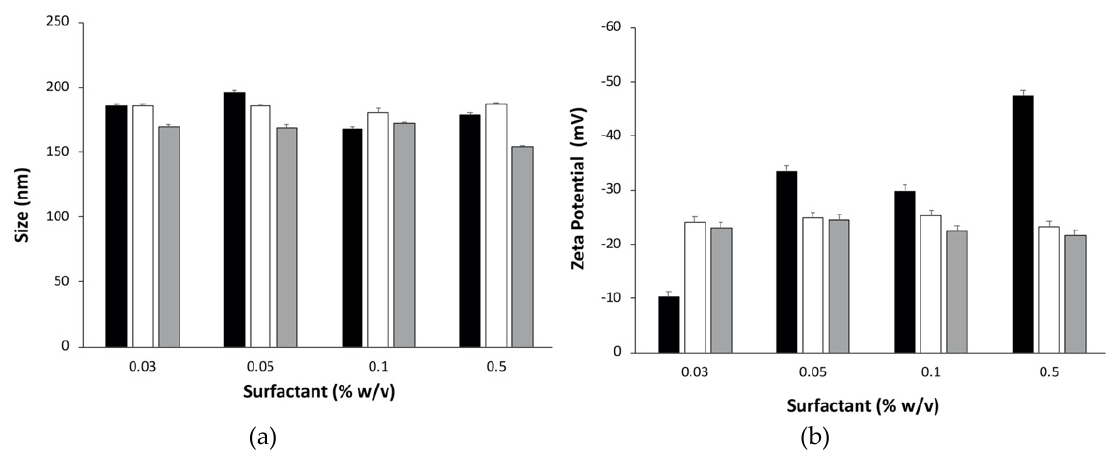
Figure 1. ( a ) Particle size and ( b ) zeta potential of PHB70 nanoparticles produced by emulsion/solvent evaporation method with 1.0% w/v PVA (Mw 10,000 Da) combined with different concentrations of tensioactives: lecithin (black bars), Pluronic F-68 (white bars) and TPGS (grey bars). Each value represents the mean and standard deviation of three independent replicates ( n = 3).